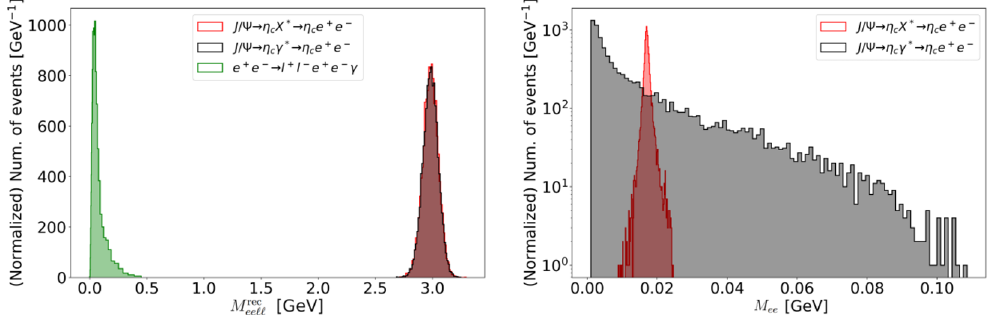
Figure 5 . The e + e − ‘ + ‘ − recoil mass (left) and e + e − invariant mass (right) distributions for the parton level Monte-Carlo simulation data with the smearing effect. Input parameter is m 17 MeV. Here, we normalized to 10 5 events for each